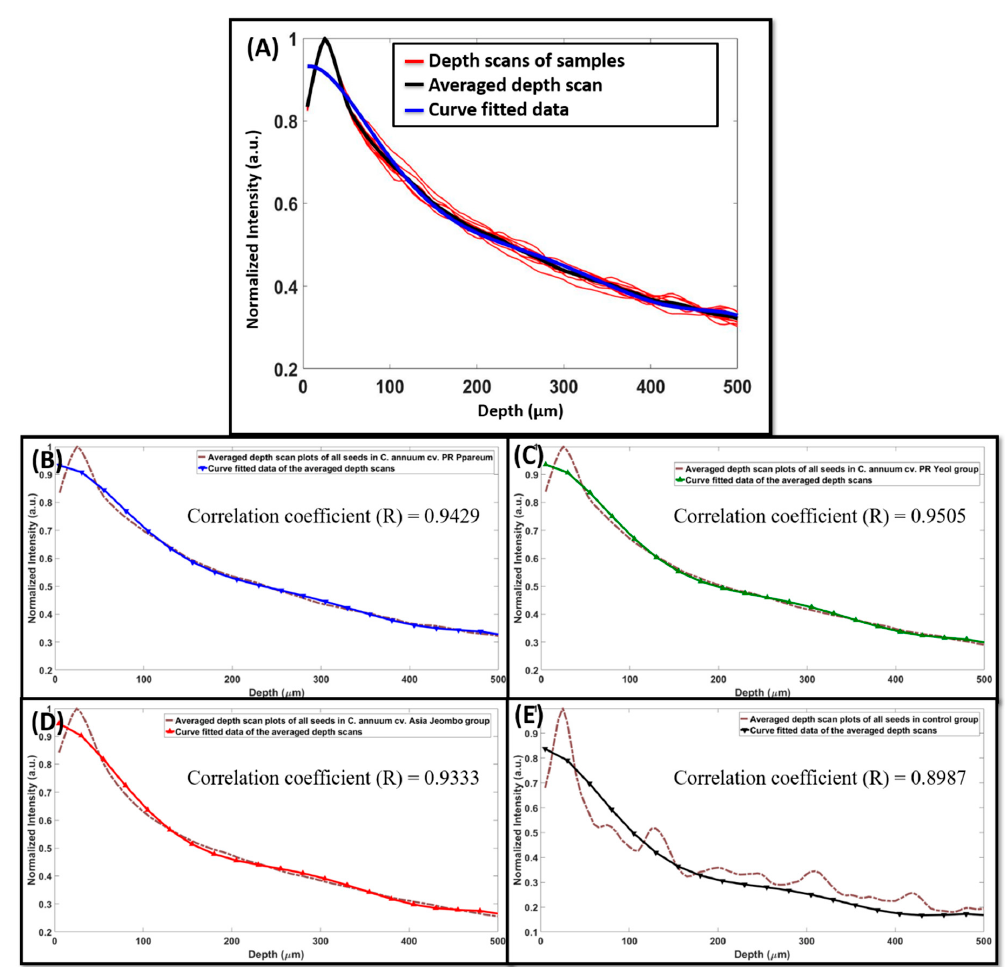
Figure 4. Curve fitting and correlation coefficient measurement. ( A ) is normalized depth scan profile and curve fitted plot of Capsicum annuum cv. PR Ppareum. It shows the normalized depth scan profiles (red) of all 10 samples, averaged depth scan (black), and curve fitted data (blue) of control category seeds. ( B – E ) are the averaged and curve fitted plots of all four groups, the correlation coefficient values are shown in the respective plots.